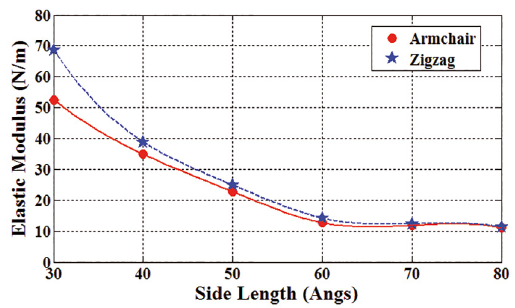
Figure 9: In-plane Young’s modulus of armchair and zigzag graphenylenes with the aspect ratio of 1.5 versus graphenylene side